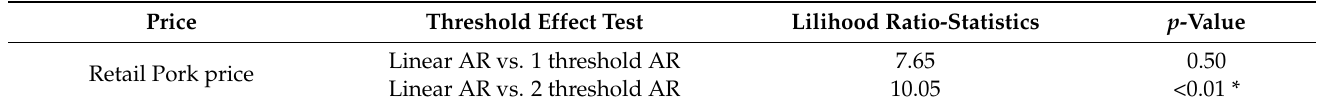
Table 2. Threshold Effect Test of African Swine Fever-related News on Retail Pork Prices. Price